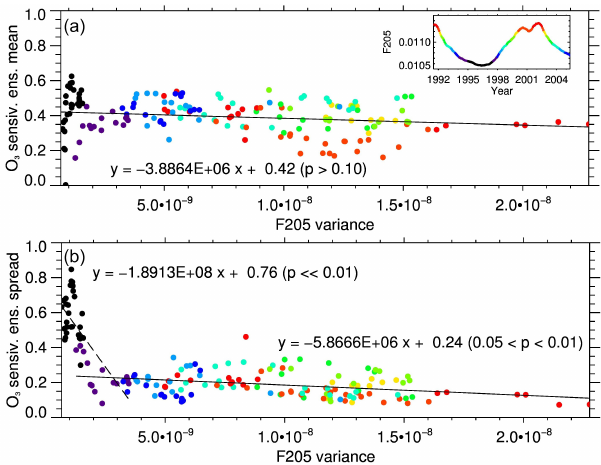
Figure 10. Scatter plots of the CCM ensemble (a) mean ozone sen- sitivity and (b) its spread (1 σ) versus the F205 variance. Dots are colored with respect to the value of the F205 flux, shown in the insert plot of (a) . Least squares linear regression fits are superim- posed (solid and dashed segments) together with their equation and the statistical significance of the slope value (in brackets; see text for details). The correlation coefficients are (a) − 0.19 ( p > 0 . 10), ( b , dashed) − 0.76 ( p < 0 . 05) and ( b , solid) − 0.36 ( p < 0 .